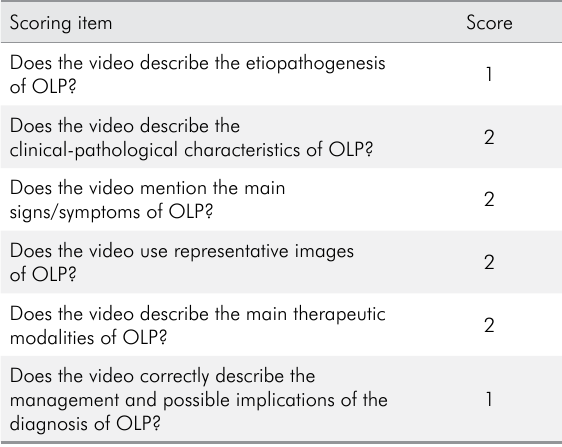
Table 1. Usefulness scoring